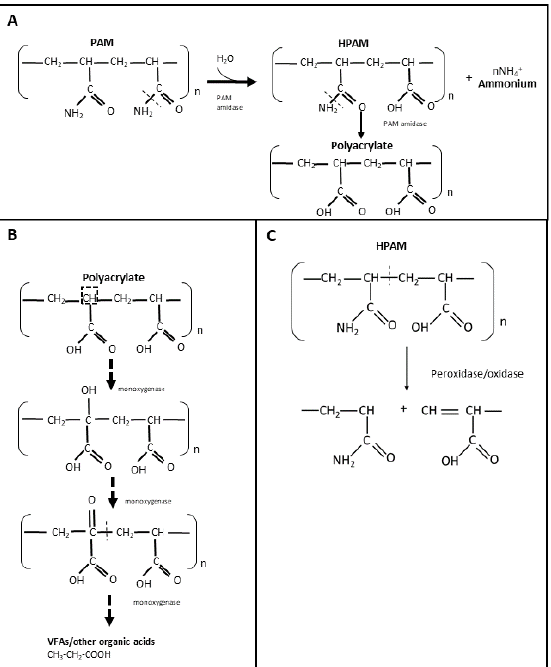
Figure 3. Microbial utilization of PAM and HPAM through hydrolyzation with amidase ( A ), sug- gested biodegradation of PAM by oxidation with monooxygenases ( B ), and PAM degradation mechanism by radical-forming enzymes ( C ).